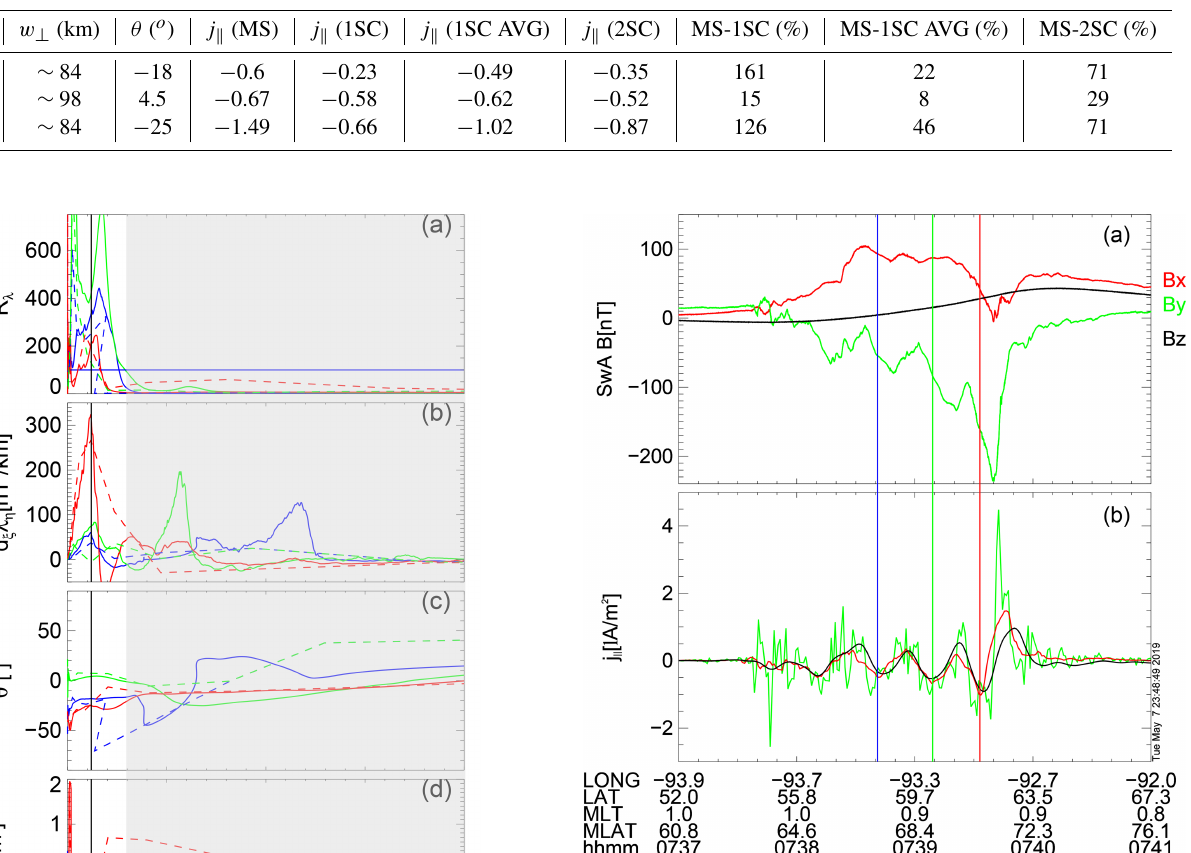
Table 2. Comparison of the FAC estimates for 15 January 2015 (same format as Table 1). This table shows additionally the average L2 single-sc FAC density (at 12s scale) and the percentage deviation obtained by comparison with the MSMVA estimate. All FAC density estimates are given in µAm − 2 , similar to Table 1.